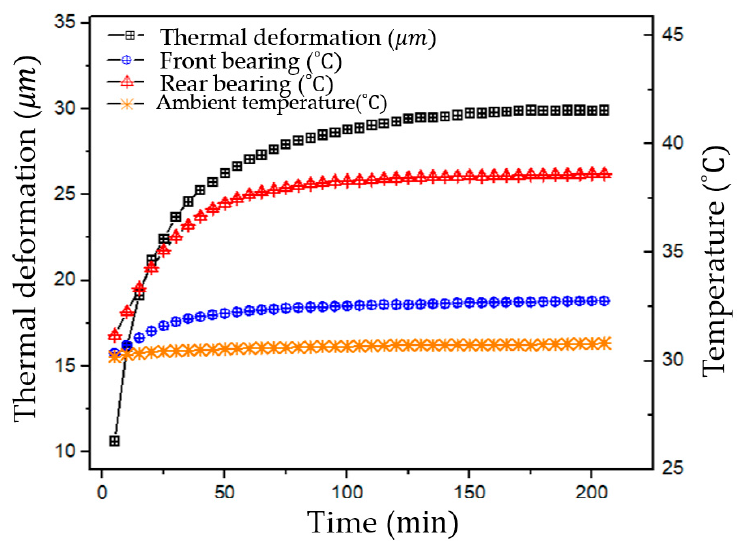
Figure 15. Thermal deformation experimental results of cooling channel with dimension optimization Thermal deformation experimental results of cooling channel with dimension design. optimization